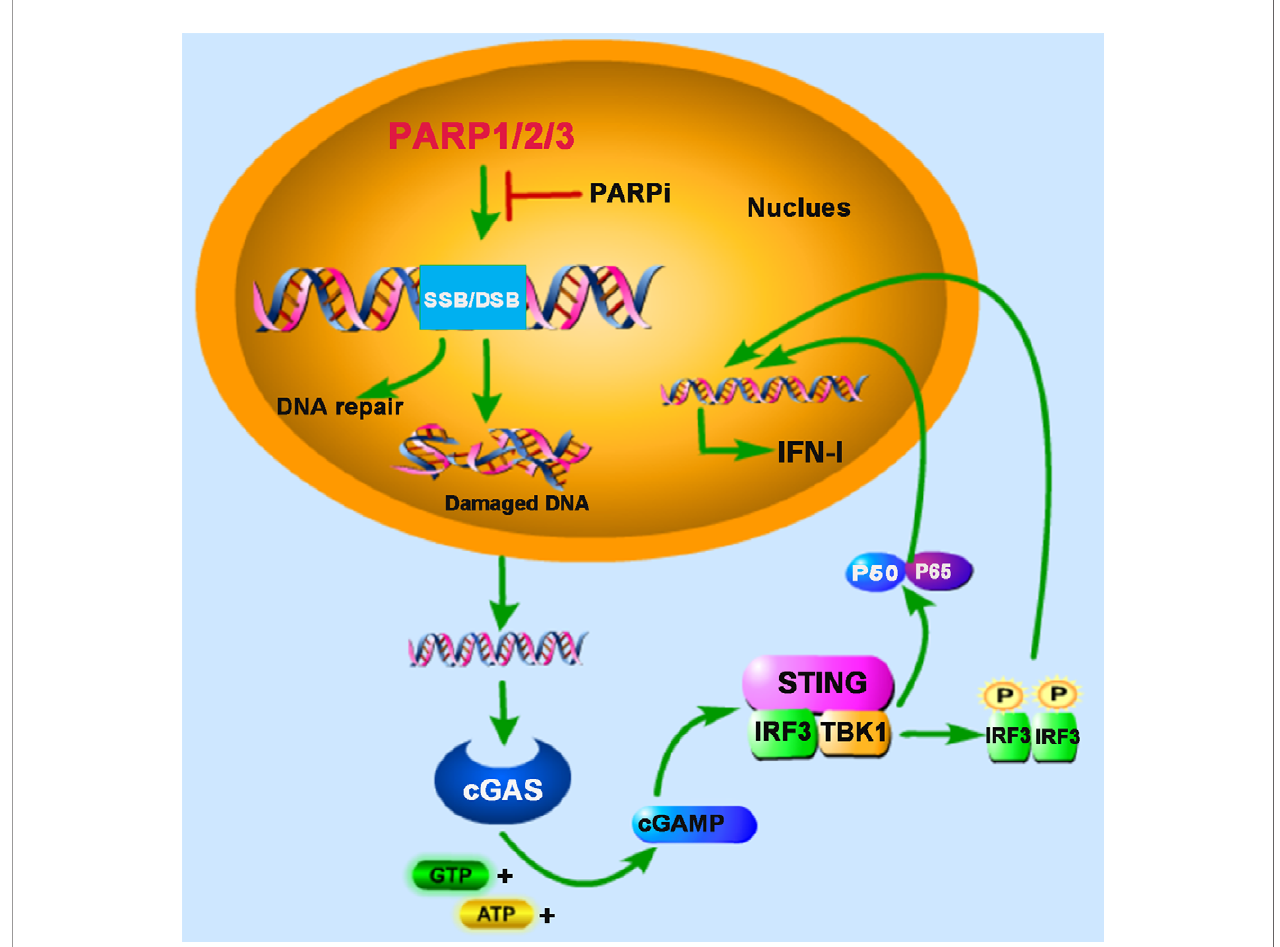
FIGURE 1 | PARPs regulate cGAS-STING-mediated innate immune responses. PARP1, PARP2, and PARP3 participate in the DNA repair process upon the DNA damage response (DDR) caused by DNA double-strand breaks (DSB) or DNA single-strand breaks (SSB). The treatment of PARP inhibitor (PARPi) prevents DNA repair, resulting in the accumulation of damaged DNA, which is recognized by cyclic GMP-AMP (cGAMP) synthase (cGAS) in the cytoplasm. The induction of type I interferon (IFN-I) is mediated by cAMP-STING-IRF3/NF- k B signaling